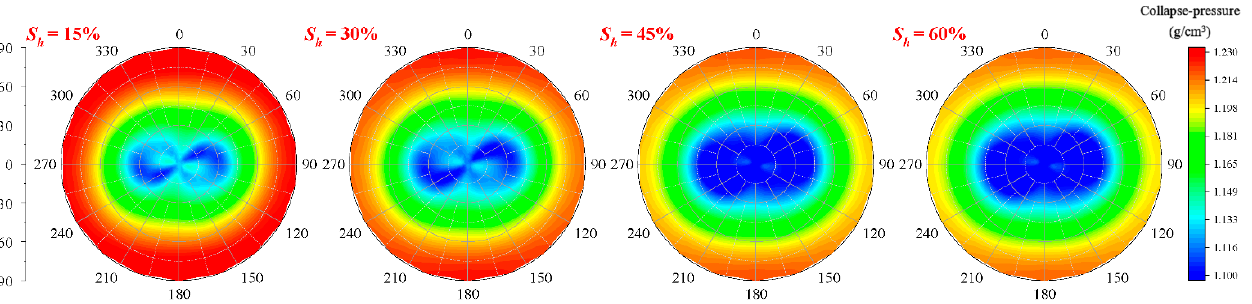
Figure 6. Cloud diagrams for the collapse pressure gradient distribution under the D-P failure cri- terion.